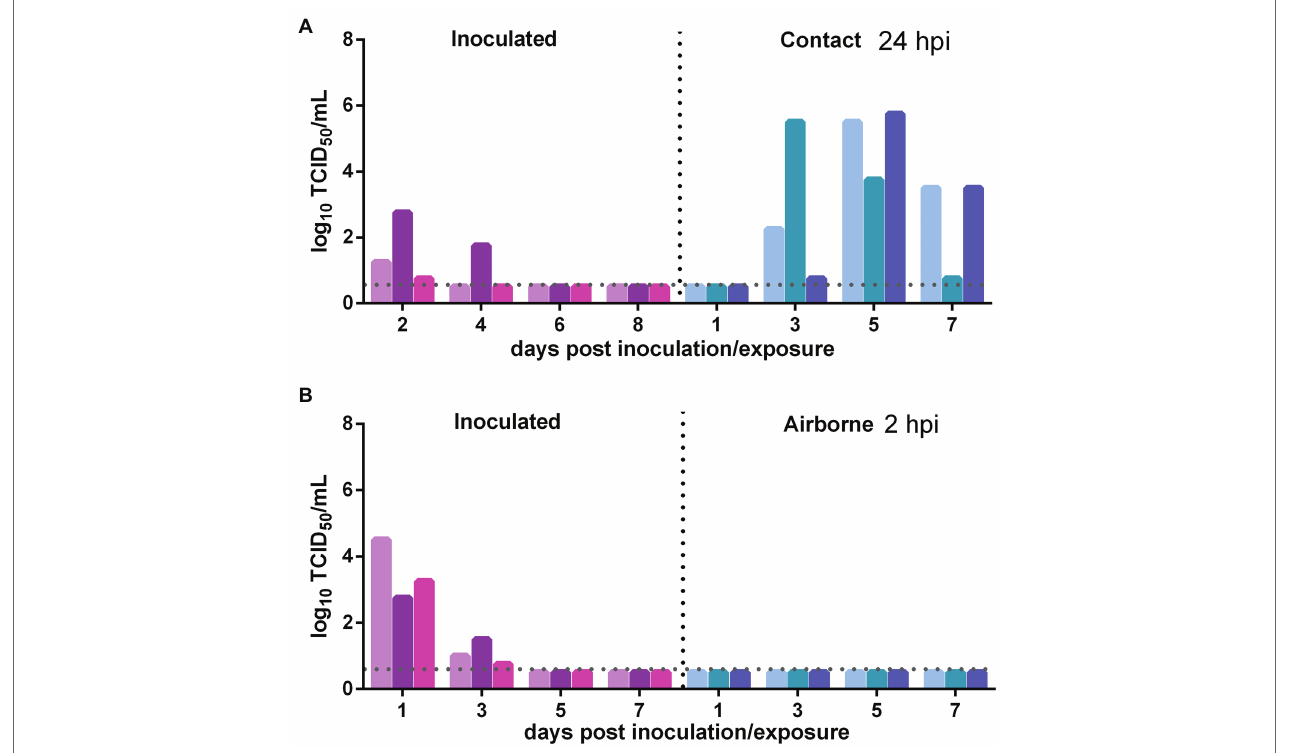
FIGURE 3 | Transmission of SARS-CoV-2 from previously infected Syrian hamsters to uninfected Syrian hamsters 24 hpi. The dotted line represents the detection limit of viral titers and colored bars are indicating individual animals. The time between infection and start of the transmission experiment was showed on the upper right side. (A) Viral titers detected in the nasal washes of previously infected donors inoculated with SARS-CoV-2 and the naïve contacts in the contact transmission experiment performed at 24 h after inoculation. (B) Viral titers detected in the nasal washes of previously infected donors inoculated with SARS-CoV-2 and the naïve recipients in the airborne transmission experiment performed at 2 h after